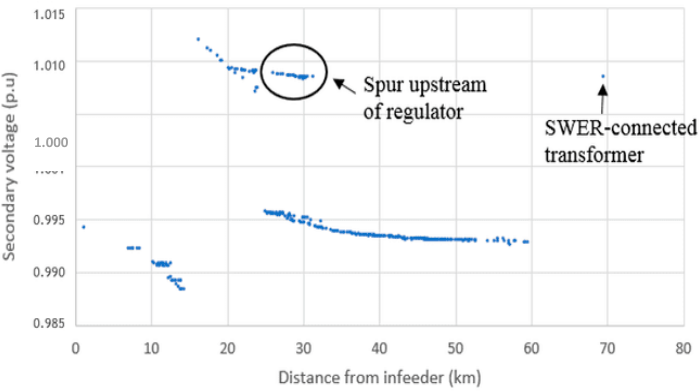
Figure 16. Secondary terminal voltage against electrical distance from the infeeder for MV/LV transformers for Case 3.